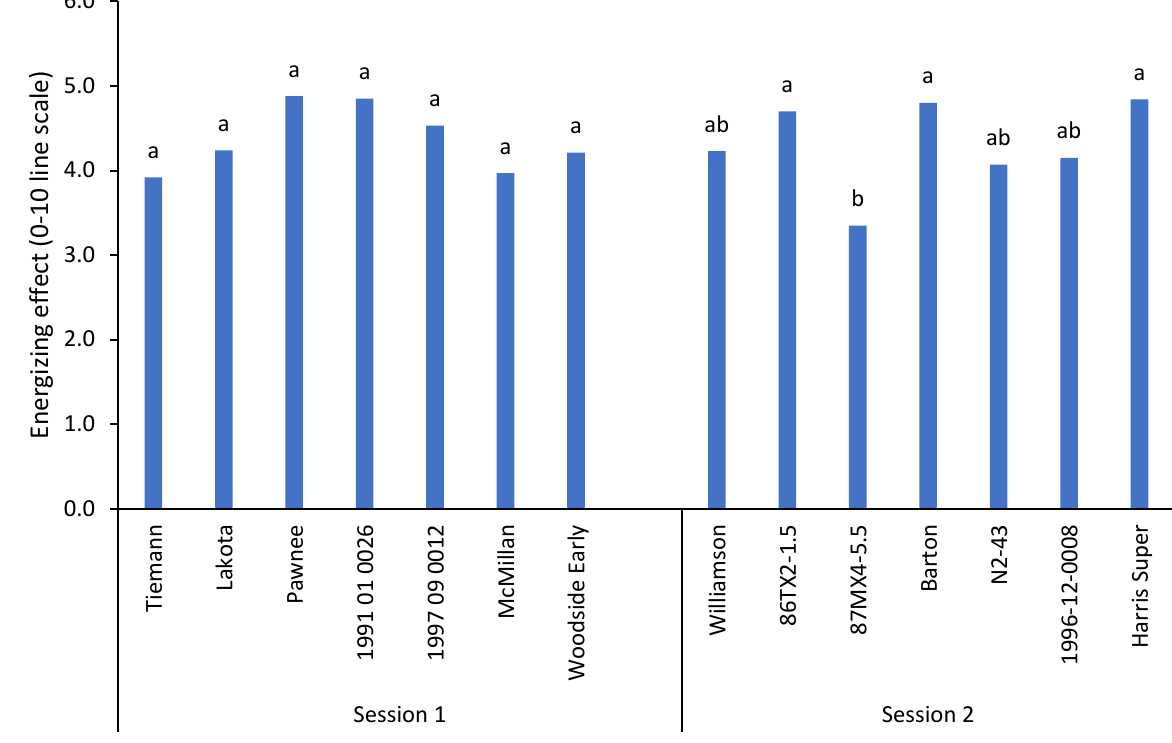
Figure 2. Consumer mean scores ( n = 99) for satiating effects of 14 pecan samples on a 0–10 line scale. Different letters ( a – c ) within attributes indicate significant differences between samples ac- cording to one-way ANOVA and Tukey’s HSD test.